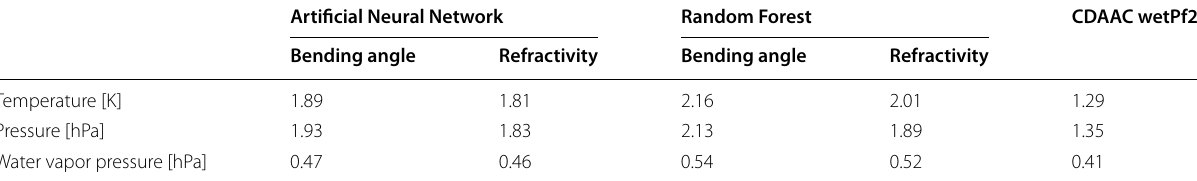
Table 2 Results of validation with